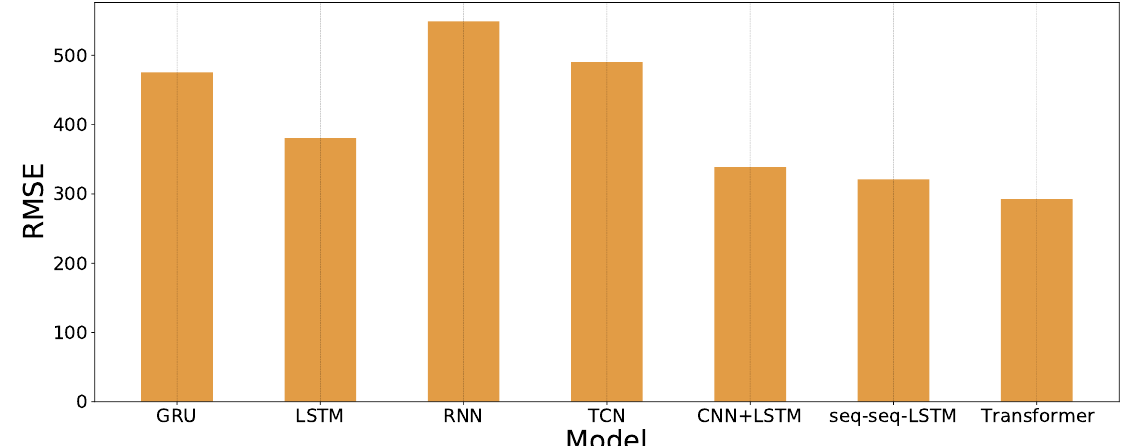
Figure 12. The average RMSE in 2010 load forecasting for seven models.